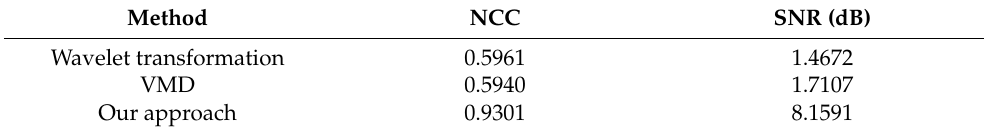
Table 1. Quantitative evaluation of the MT data denoised by different methods.